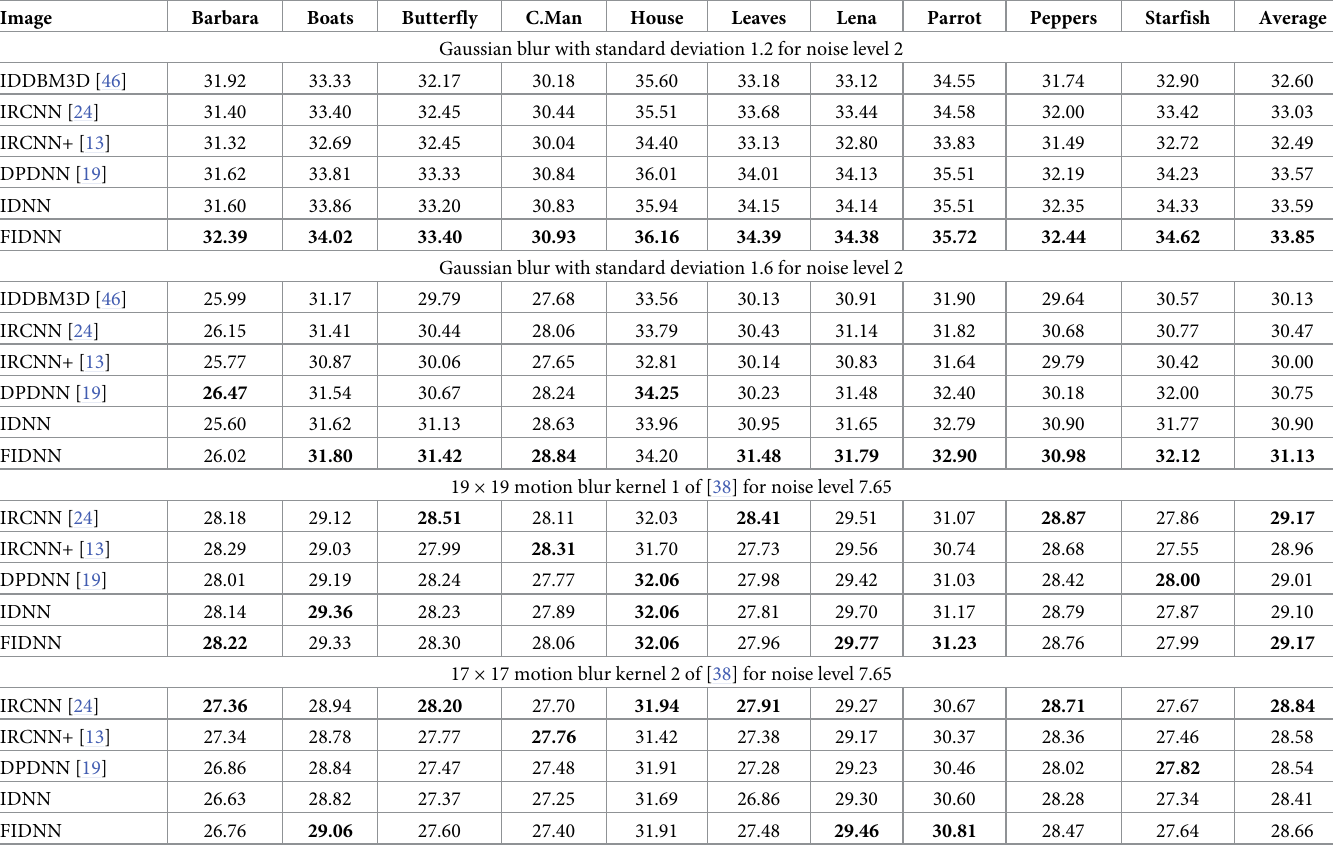
Table 5. PSNR results of deblurring by different methods on Set10 dataset.